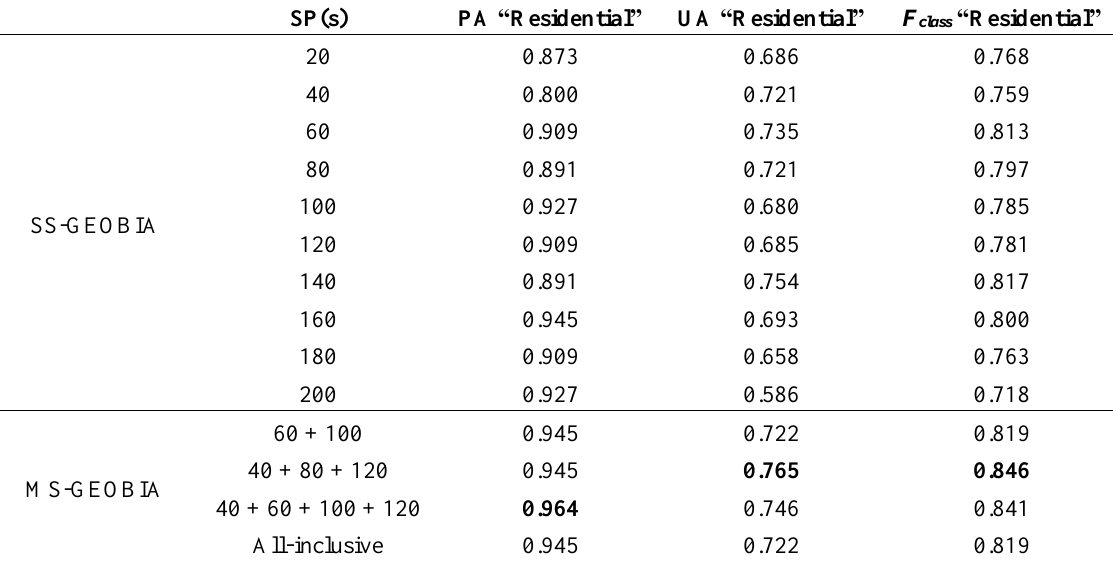
Table 2. Overall accuracy (OA), producer’s accuracy (PA), user’s accuracy (UA), and F-measure ( F class ) of the SS-GEOBIA and MS-GEOBIA approaches. Bold values show the most accurate results for each metric. The multiple SPs used for the MS-GEOBIA approaches are separated by the “+”